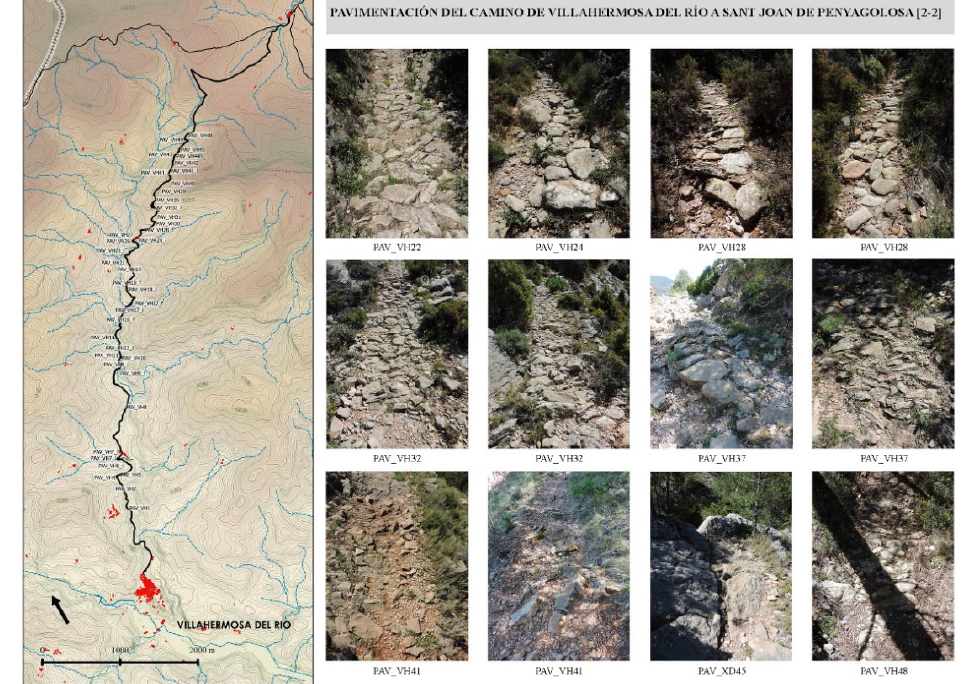
Figure 7. Descriptive card of the cataloguing of pavements. The sheet included a plan with the catalogued points and images of the areas with their cataloguing code.